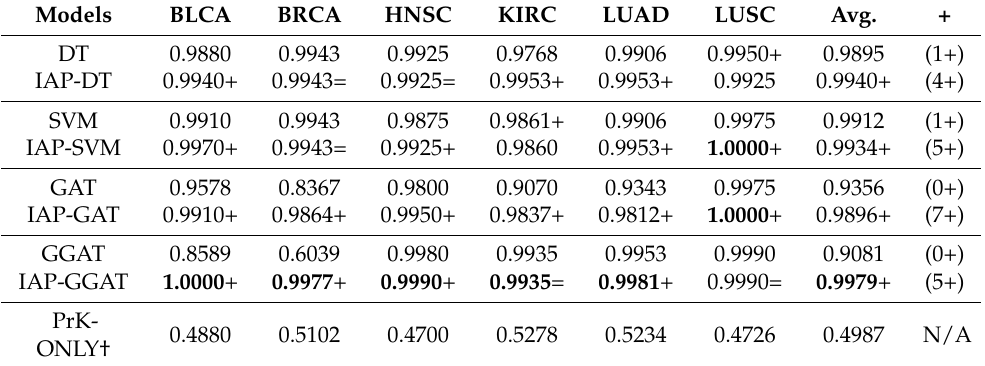
Table 3. Accuracy on all datasets. (†) PrK-ONLY: a naïve model that only facilitates the PrK for prediction.